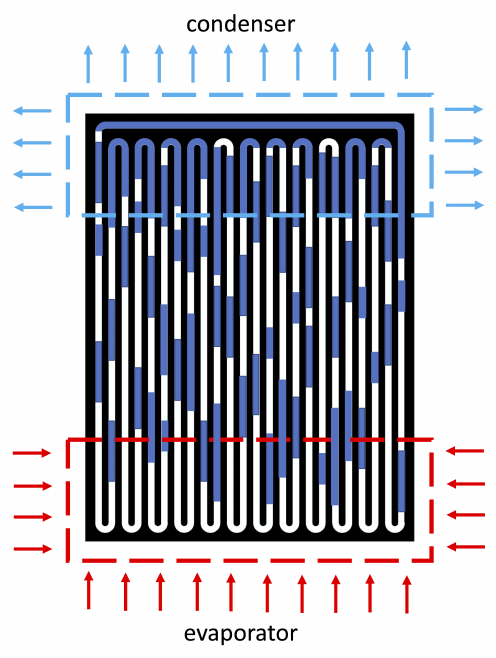
Figure 7. Schematic of a pulsating heat